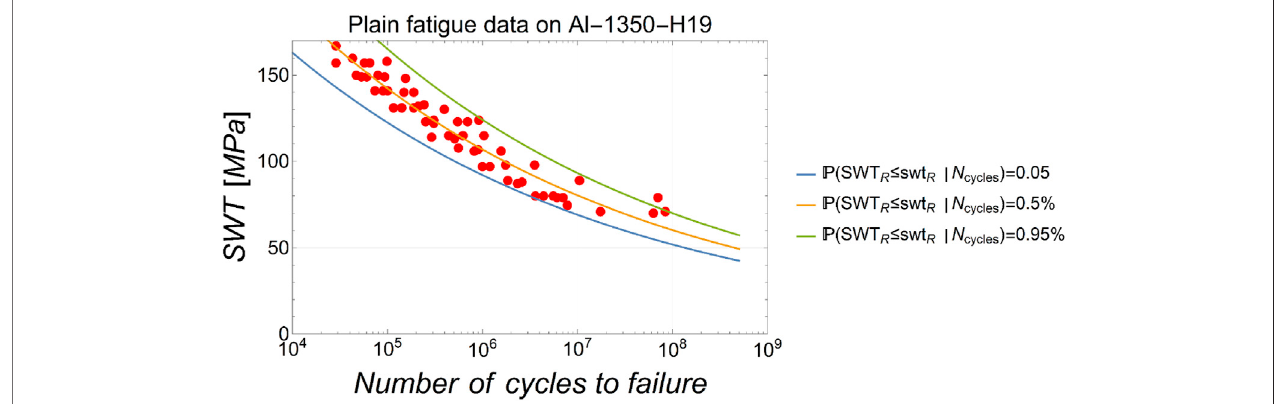
FIGURE 8 | Fatigue data obtained from Kaufman (2008) and the fi tted fatigue